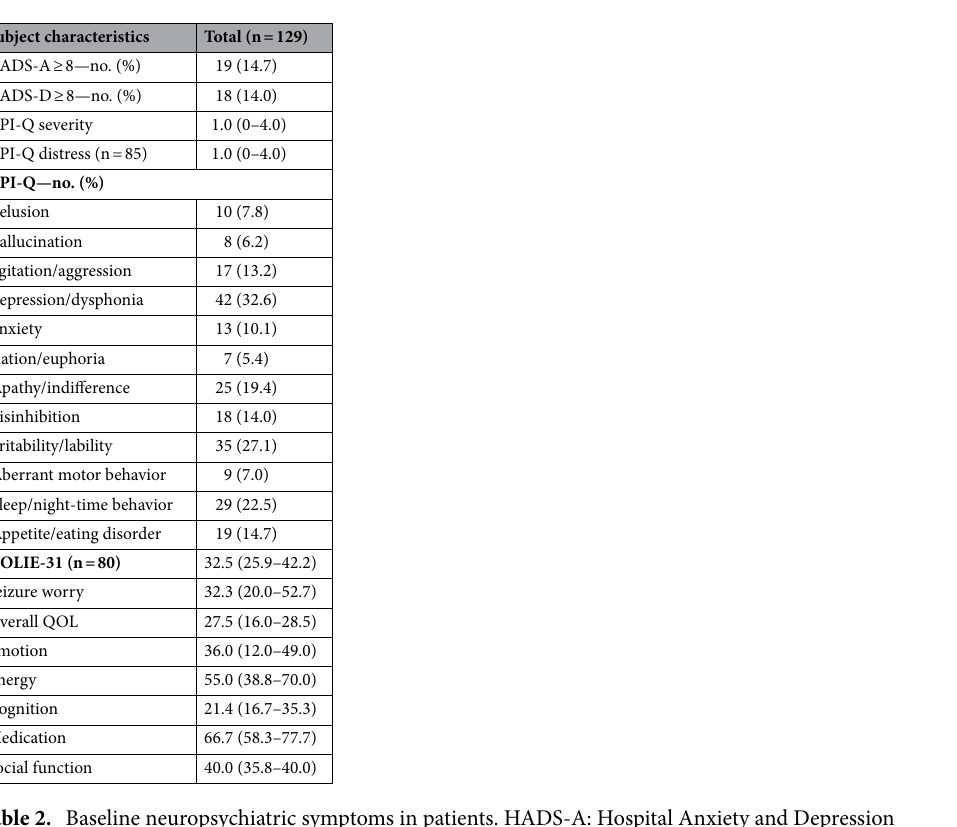
Table 2. Baseline neuropsychiatric symptoms in patients. HADS-A: Hospital Anxiety and Depression Scale-Anxiety; HADS-D: Hospital Anxiety and Depression Scale-Depression; NPI-Q: Neuropsychiatric Inventory-Questionnaire; QOL: Quality of life. Data are reported as the number (percentage), or as the median (interquartile range,